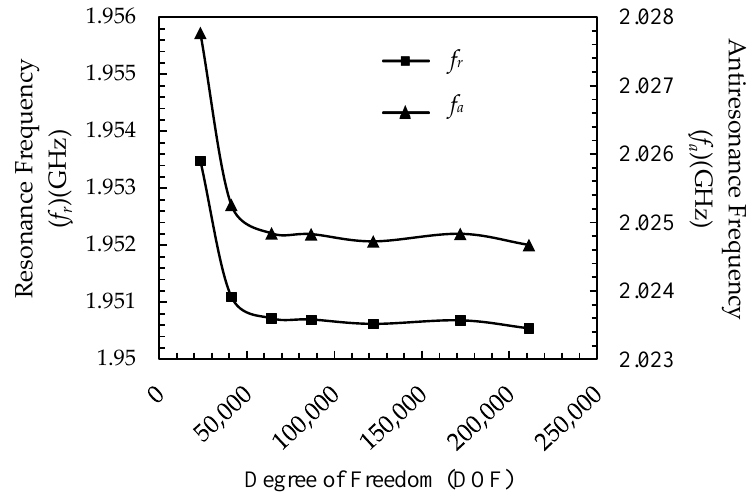
Figure 3. Convergence study of COMSOL FBAR FEM model.